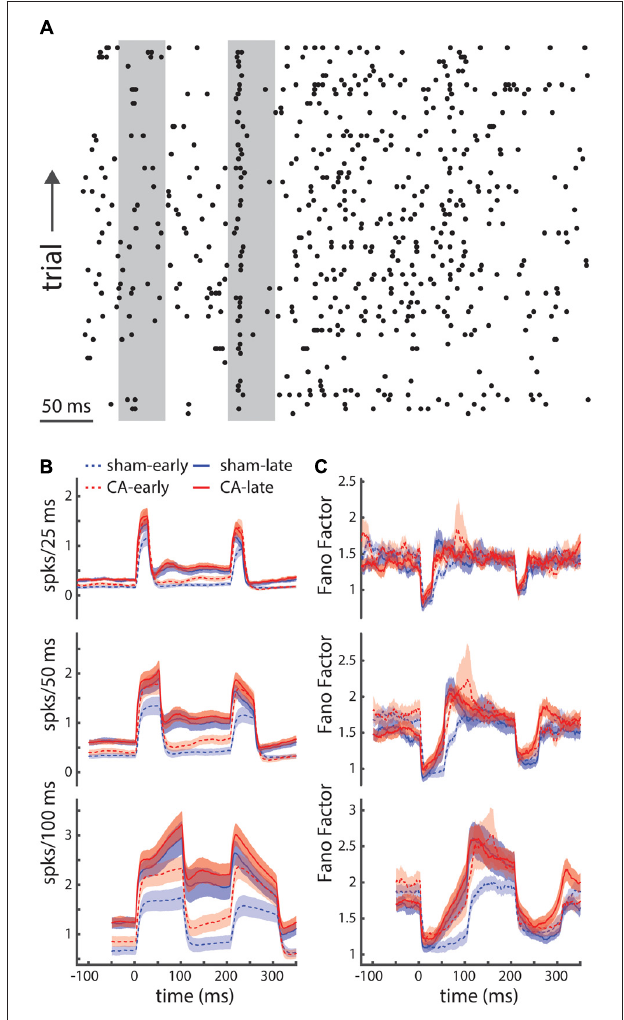
FIGURE 3 | Relative spike-count variability is unique for early sham rats. (A) A spike raster plot displaying the relatively high trial-to-trial variability of thalamocortical neurons in the ventral posterior medial (VPm) nucleus. (B) Time dependent firing rates are calculated by convolving spike counts with sliding square-wave windows of different widths (25 ms, 50 ms and 100 ms; top-bottom). (C) The time-dependent Fano factor (spike count variance divided by mean count), using different counting windows (top-bottom: 25 ms, 50 ms, 100 ms), reveals stimulus dependent reduction in spike count variability. Using a large counting window (100 ms) we are better able to estimate the Fano factor and start to see systematic differences in the pattern of relative variability of sham-early spiking activity compared to other groups: both CA-early and late groups. Shaded regions indicate